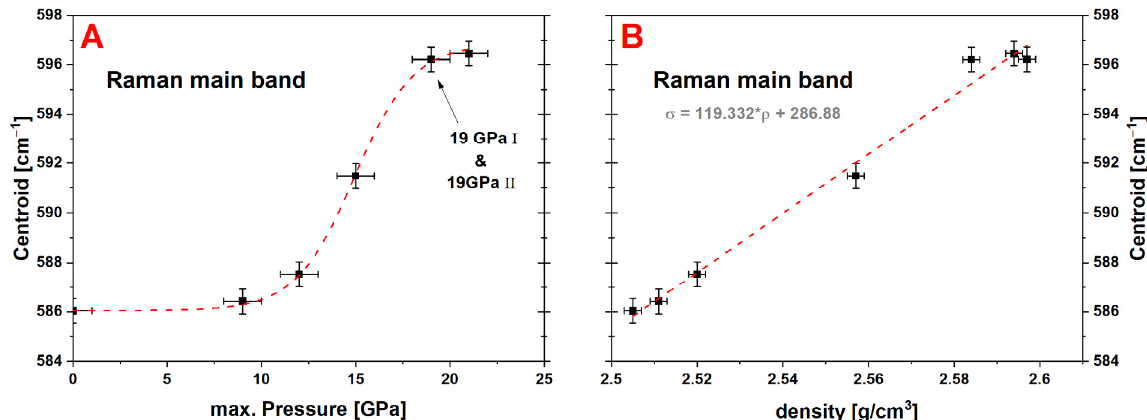
Figure 8. Evolution of the centroid of the Raman main band versus the maximum pressure ( A ) and the measured density ( B ); a variation of ~10 cm − 1 can be observed from the pristine glass sample (~586 cm − 1 ) to the maximal densified sample at 21 GPa (~596 cm − 1 ); a fitted maximal variation Δ = 10.82 ± 0.15 cm − 1 with P inflection = 14.9 ± 0.1 GPa and m = 0.16 ± 0.01 is reported in relation to P max , a linear dependency between the centroid and the density can be deduced (relation is given in the corresponding graph).